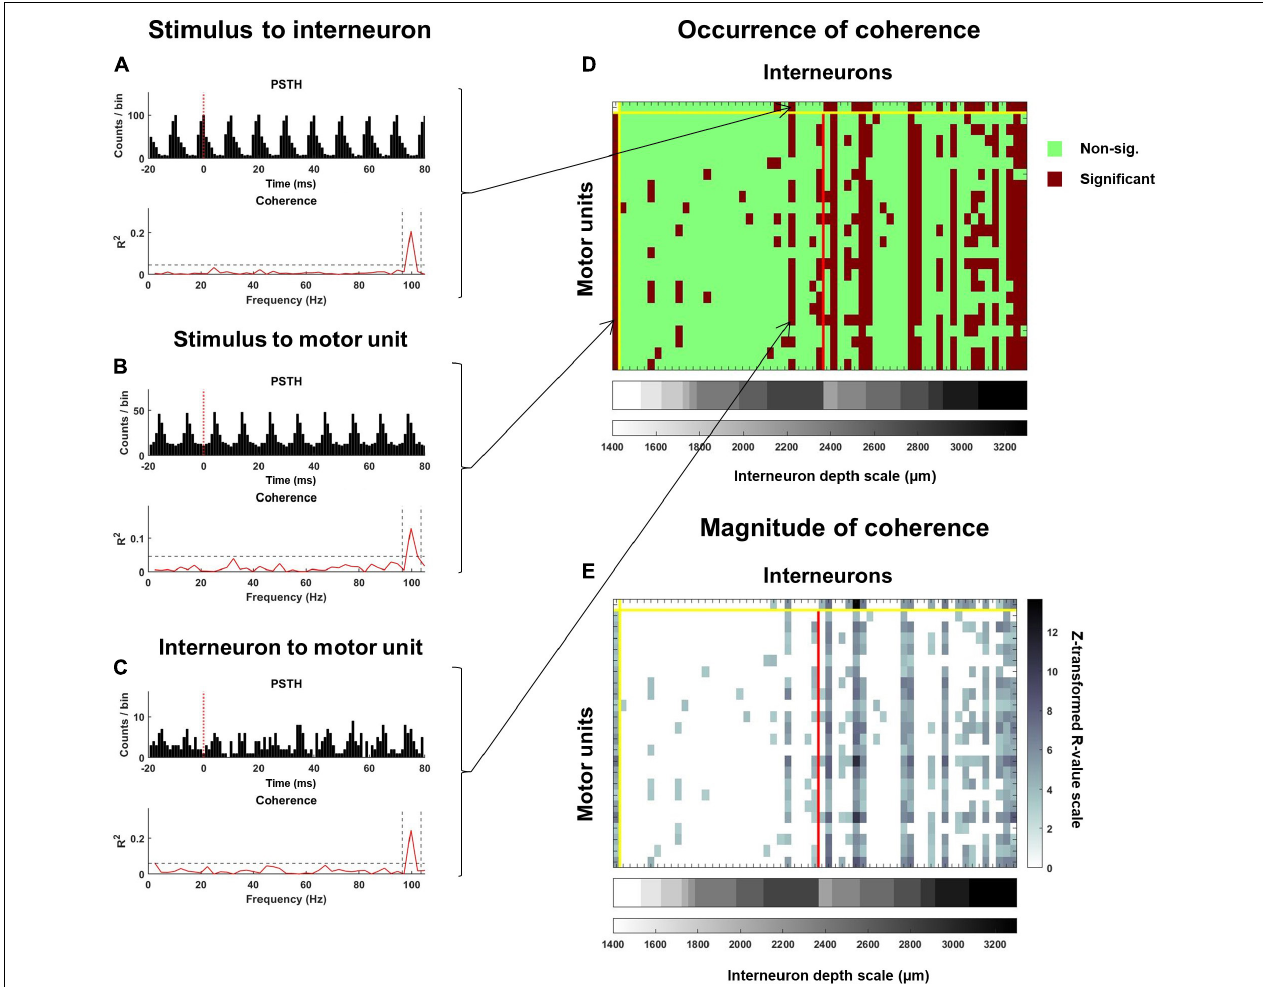
FIGURE 5 | Coherence analysis used to examine the response of interneurons and motoneurons to the stimulus pulse train as well as the functional connectivity between interneurons and motoneurons. Exemplar PSTH and coherence spectra for (A) an interneuron spike train relative to the stimulus, (B) a motor unit spike train relative to the stimulus, and (C) a motor unit spike train relative to an interneuron spike train. On each plot of the coherence spectra, a dashed horizontal line represents a 99% confidence limit. Coherence values exceeding this confidence limit at the stimulation frequency (identified with vertical dashed lines), were considered significant. The occurrence of significant coherence is mapped onto the matrix illustrated in panel (D) . The top row indicates interneurons that were and were not significantly cohered to the stimulus pulse times, while this same information for each motor unit is provided along the first column. All subsequent columns starting after the second row indicate instances where an interneuron was significantly cohered with a motor unit. The red vertical line separates interneurons that were recorded at the rostral (left) and caudal (right) spinal segments. Interneurons are further stratified according to depth, with deeper interneurons at each recording site being plotted further to the right. For all significant relations, the peak of coherence (after z-transformation) at the stimulation frequency was calculated. The magnitude of coherence between the stimulus and each interneuron and motor unit, and between each interneuron and motor unit for this exemplar trial is mapped onto the matrix in panel (E)